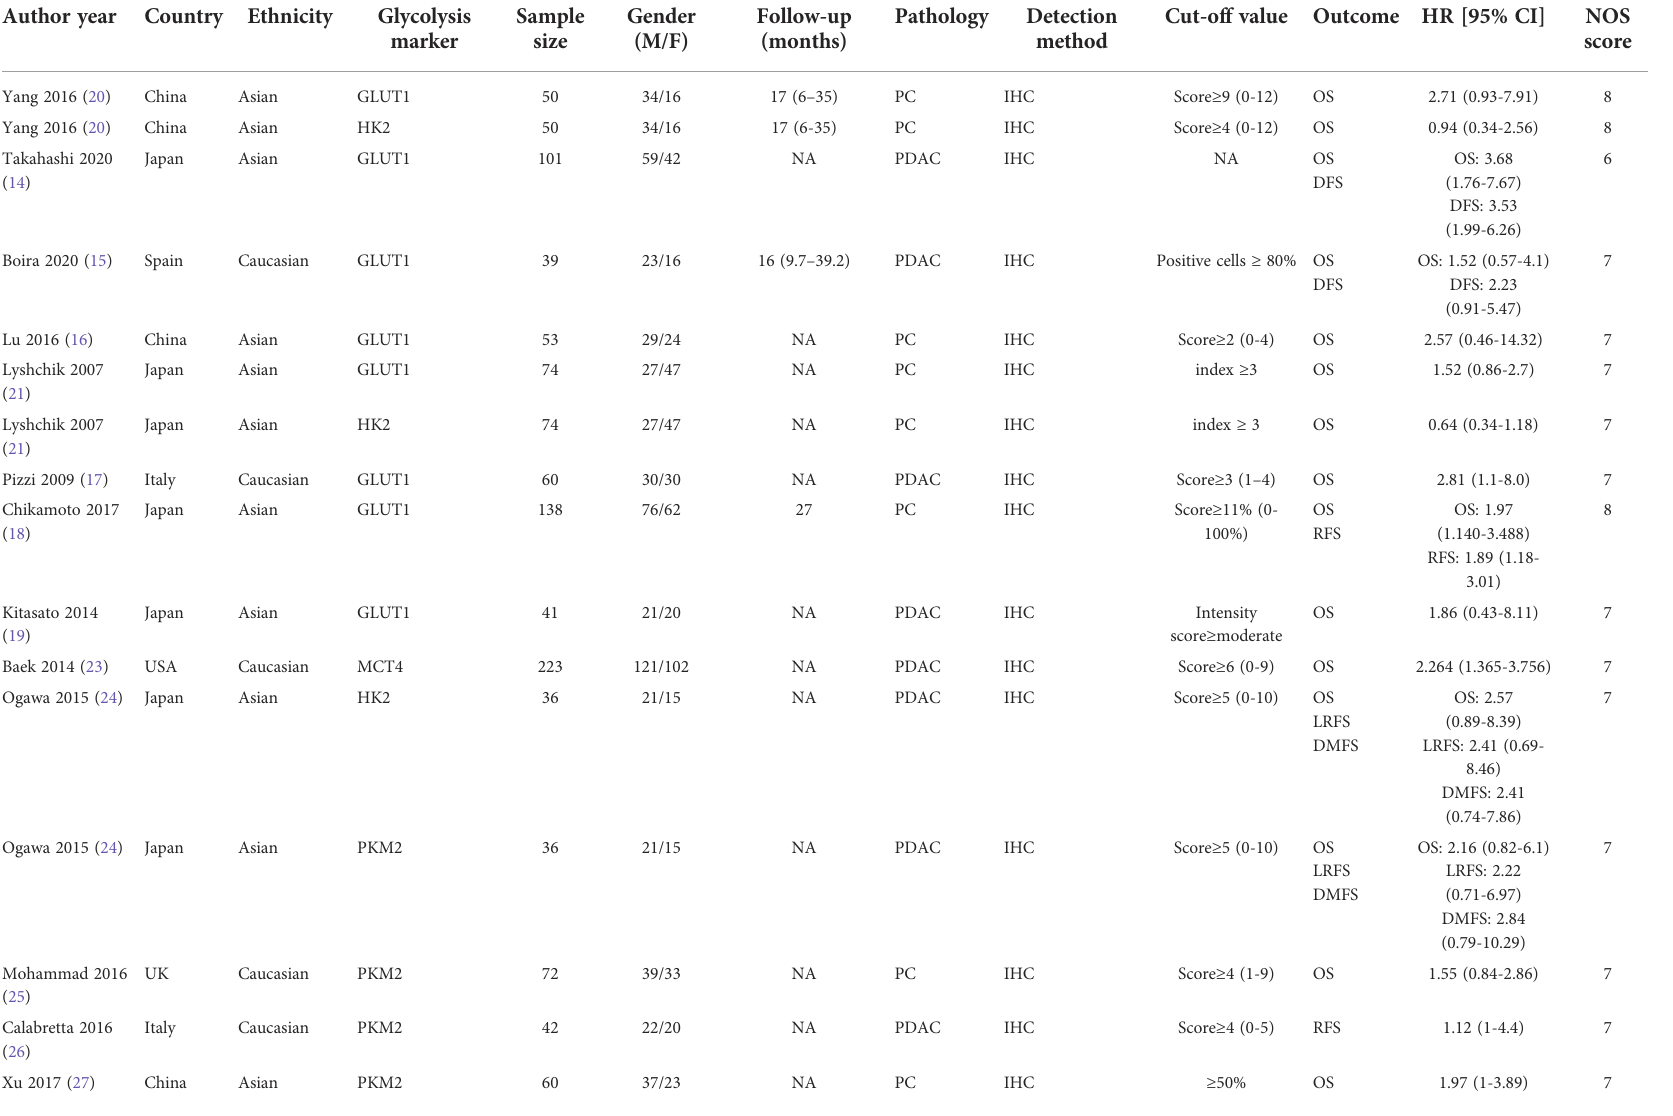
TABLE 1 Characteristics of included